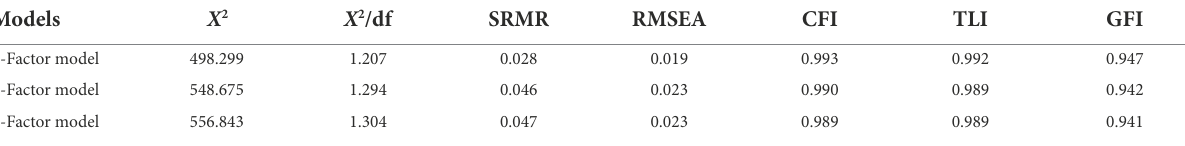
TABLE 3 Model fit comparison.